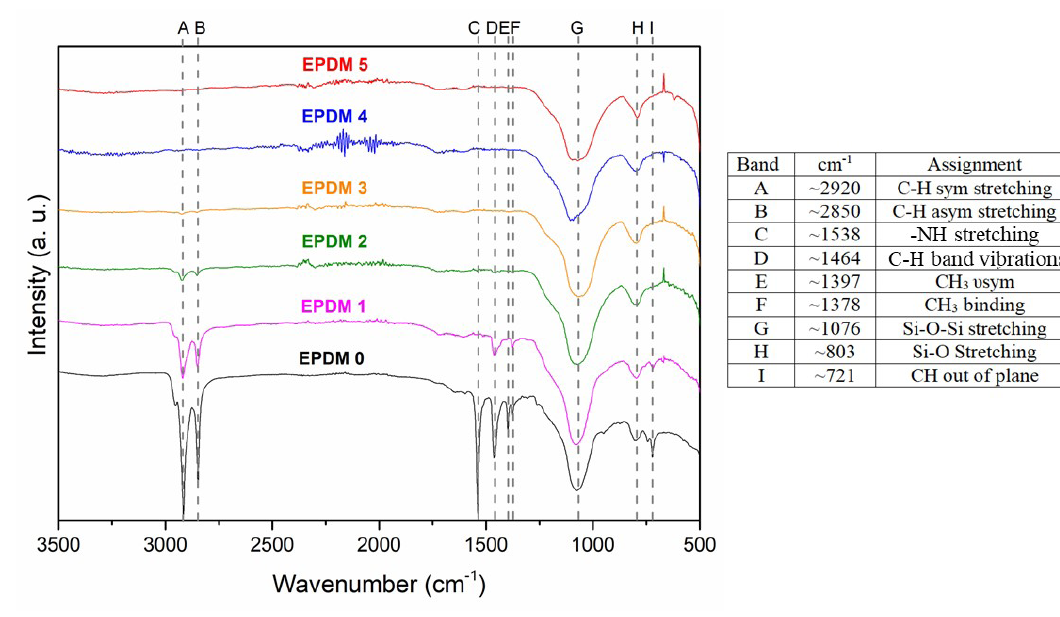
Figure 10. FTIR of the control sample (EPDM 0) and the ablated samples EPDM 1, 2, 3, 4, and